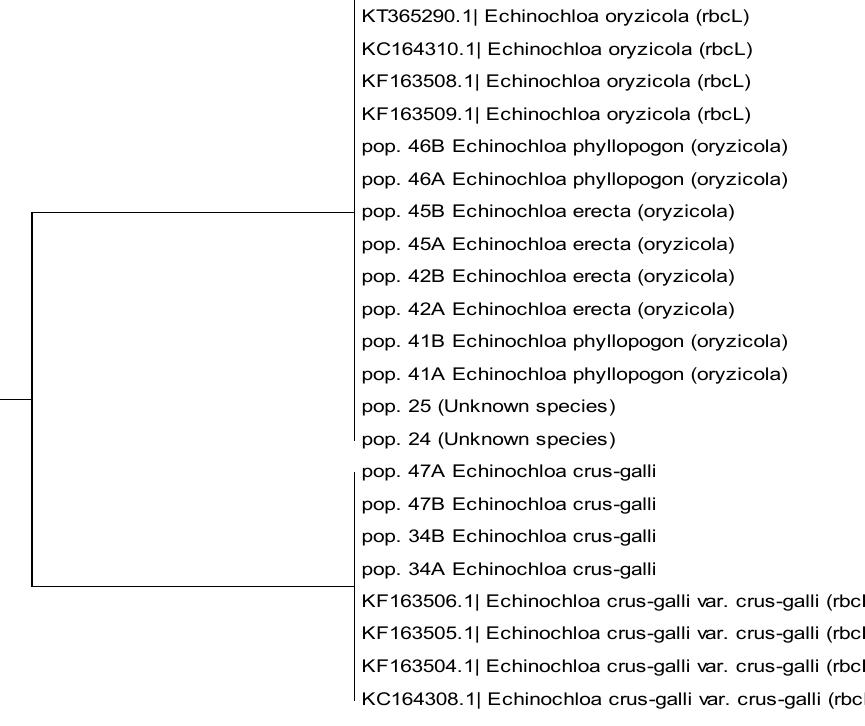
Figure 2. Results of CAPS-rbcL molecular marker for a selection of samples tested: plants belonging to “white” species, E. oryzicola (161S, 44R, 45R and 46R), show the two digested bands at 134 and 87 bp, whereas plants belonging to “red” species, E. crus-galli (16S, 95R and 100R) show a single band. 3.3. Southern Blotting with ALS Gene The DIG-labeled DNA probe of 360 bp corresponding to a conserved region including region B of the ALS gene (corresponding to amino acid positions 573–576) was used to detect the homologous fragments on genomic DNA blots. This led to quantifying the number of ALS loci in different Echinochloa species’ genomes with different herbicide resistance patterns. The experiments gave variable results depending on the endonuclease used: results of hybridization of the DNA fragments digested with HindIII in the first (Figure S6A) and third experiments (Figure 3) and with XbaI (Figure S6B) in the second one revealed that one more copy of the ALS gene was present in the E. crus-galli